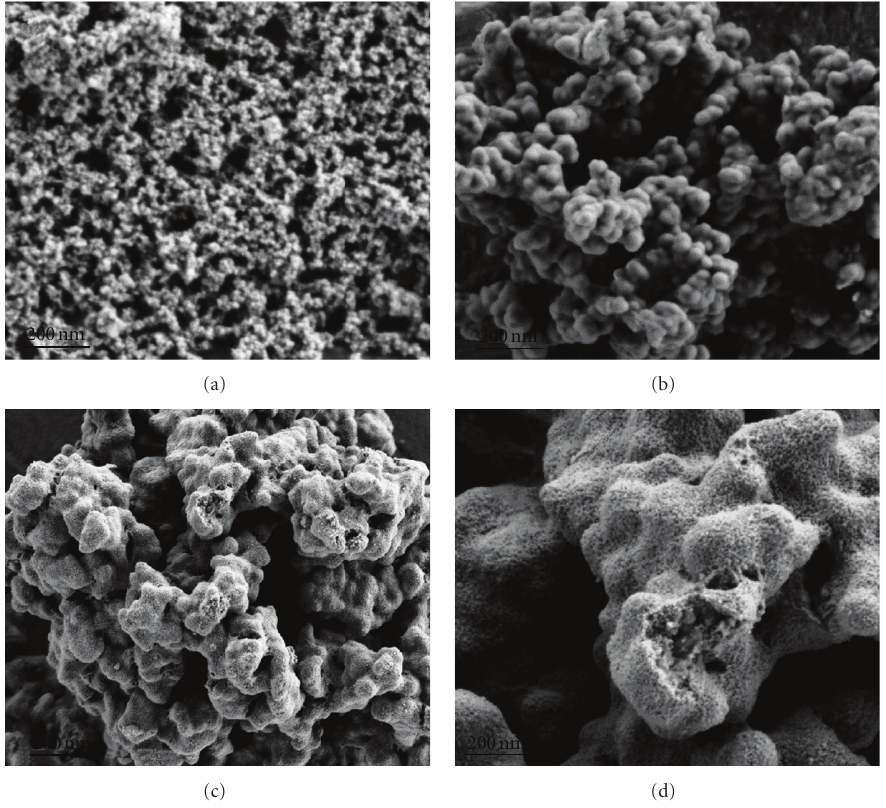
Figure 3: FE-SEM images of Fe 3 O 4 (a) and Fe 3 O 4 /SiO 2 (b) Fe 3 O 4 /SiO 2 /TiO 2 composite microspheres (c, d).